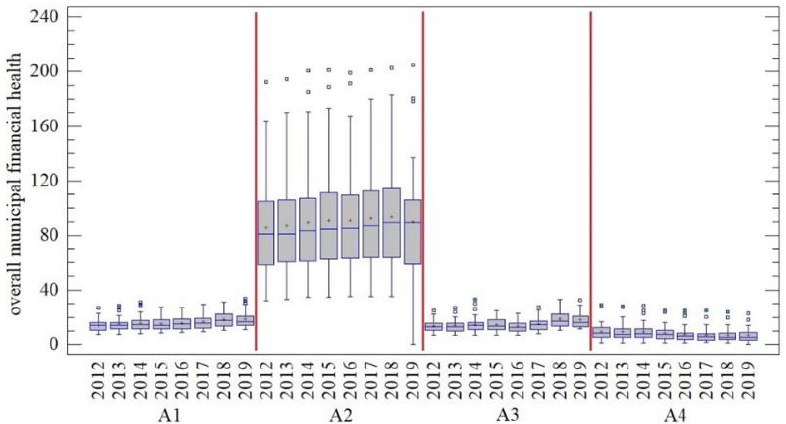
Figure 2. The overall financial health of the municipality based on a single indicator (A1, A2, A3, A4) during the 2012–2019